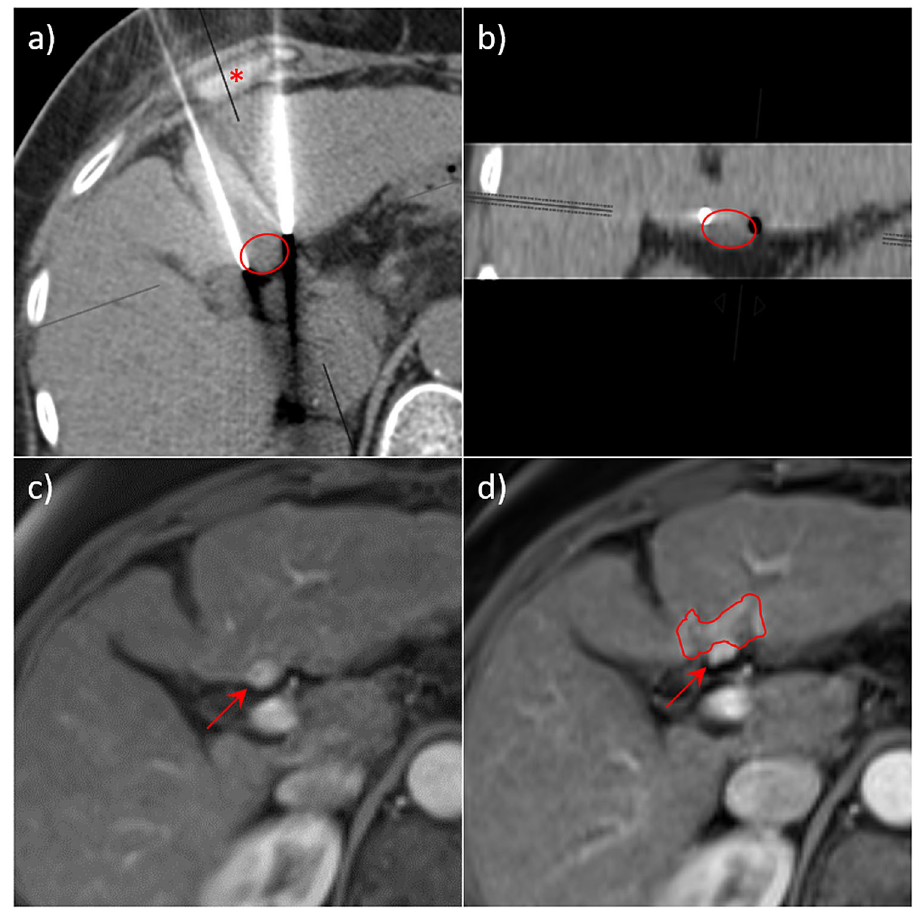
Figure 4. Example of an IRE with residual tumor after ablation with 2 needles. ( a ) and ( b ) show multi-planar reconstructions (MPRs) of the computed tomography (CT) with needle placement immediately before ablation of a hepatocellular carcinoma (HCC), ( a ) in parallel alignment to the needle plane, ( b ) orthogonal to it. The tumor location is outlined as red circle. Here 1. the needle depth was insufficient (Ndep = 11 mm) due to the subcapsular location of the tumor, 2. the needle divergence was high (Ndiv = 8.5°) because of the unfavourable interposition of the rib cartilage (asterix) and 3. the tumor was slightly caudal to the needle plane. This results in a high tumor-center-to-ablation-center distance (TACD = 10 mm). ( c ) Contrast enhanced magnetic resonance imaging (MRI) before ablation showing the hypervascularised HCC (arrow). ( d ) residual tumor 6 weeks after ablation. The distorted ablation area, which spares the tumor area, is outlined in